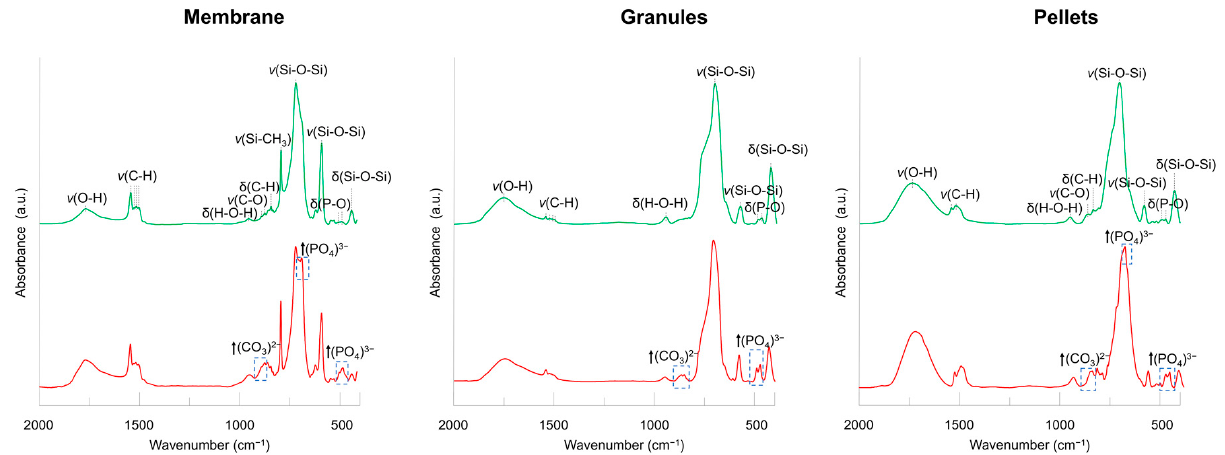
Figure A1. SEM-EDX micrograph of primarily obtained membrane after 21 days of immersion in simulated body fluid.